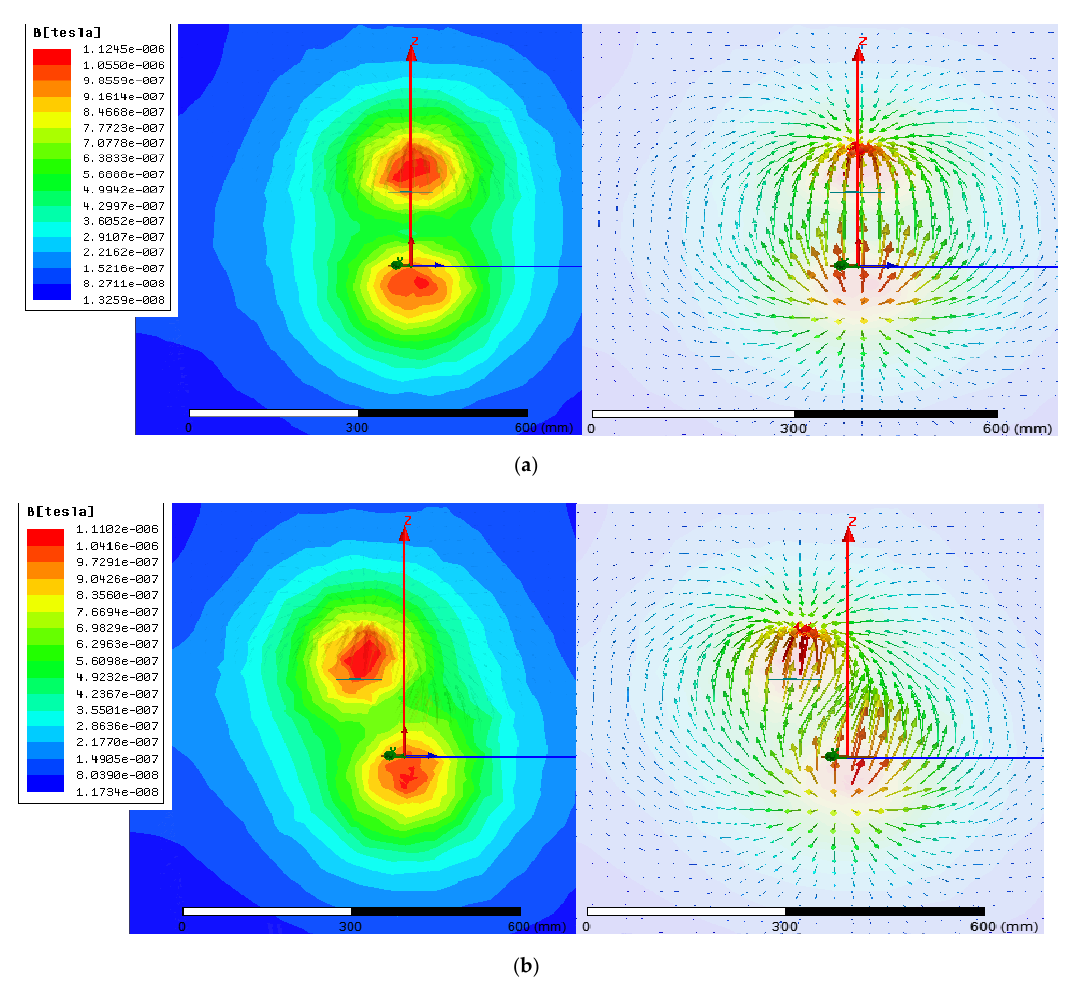
Figure 9. Distribution of the flux density: ( a ) D = 0, ( b ) D = − 80.